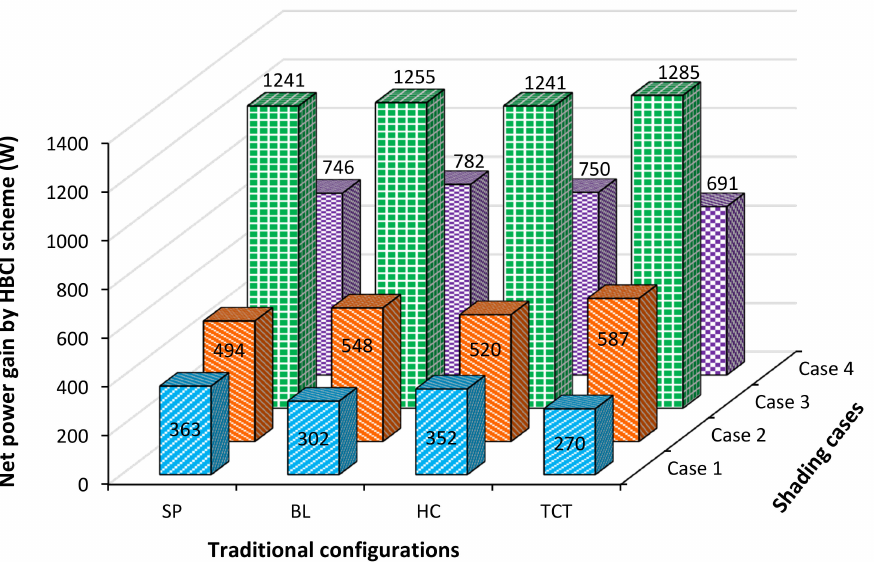
Figure 14. Net power gain by the proposed reconfiguration and the HBCI scheme compared to the traditional schemes (SP, series parallel; BL, bridge link; HC, honeycomb; TCT, total cross tied) for different cases (single panel, corner, long and wide, random) of PV array shading (net power gain = HBCI power output-power output by a traditional scheme-HBCI power